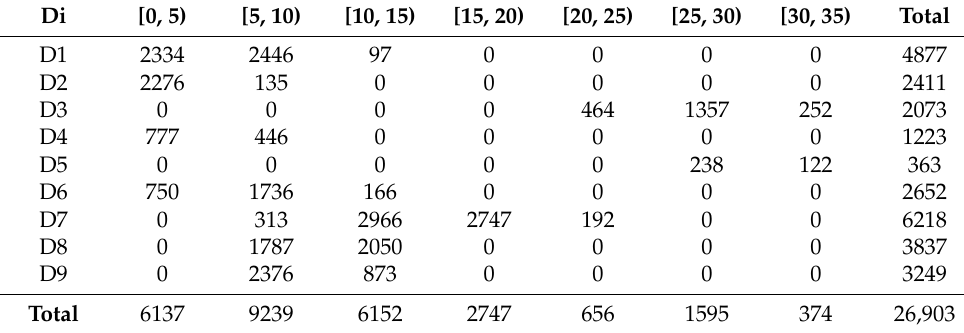
Table 2. Relationships between districts and distance from the epicenter.